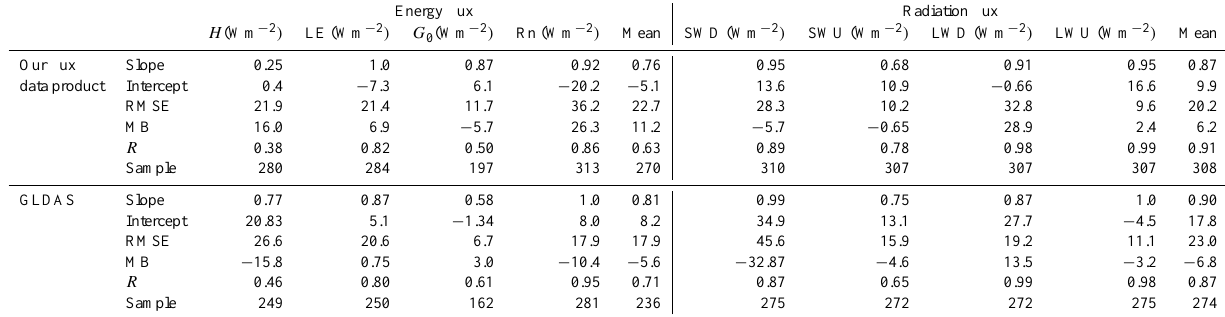
Table 3. Comparison of the accuracy of our flux data product and GLDAS against in situ measurements from 11 Chinese flux towers. MB is the mean of the observation minus the model simulation.